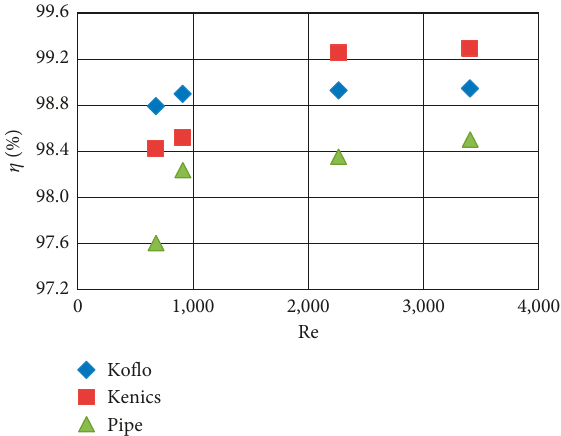
Figure 7: The conversion rate of fluorides removal as a function of the Reynolds